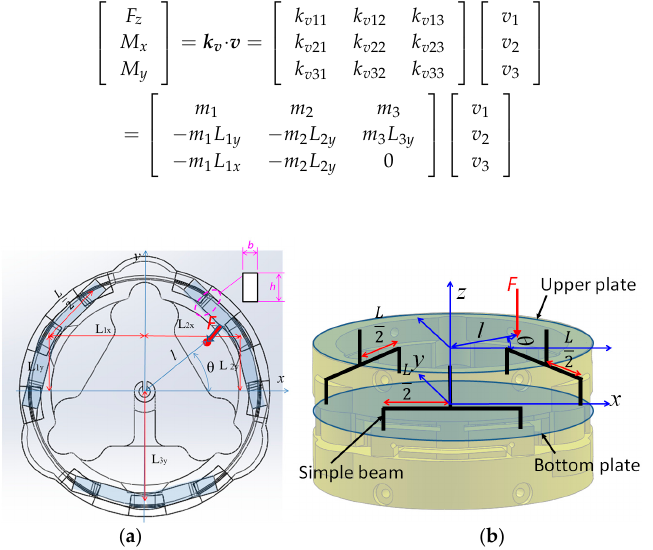
Figure 6. Sensor structure (section of simply-supported beam) dimension and design variables (L = 6 mm, L 1 x = 9.3 mm, L 1 y = 5.4 mm, L 2 x = 9.3 mm, L 2 y = 5.4 mm, L 3 y = 10.8 mm, h = 1.5 mm, and b = 1.5 mm): ( a ) The top view; ( b ) The side view.